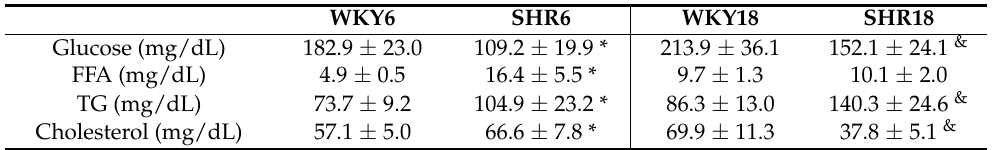
Table 1. Concentrations of plasma glucose, FFA, TG, and cholesterol in WKY and SHR rats at 6 and 18 weeks of age.